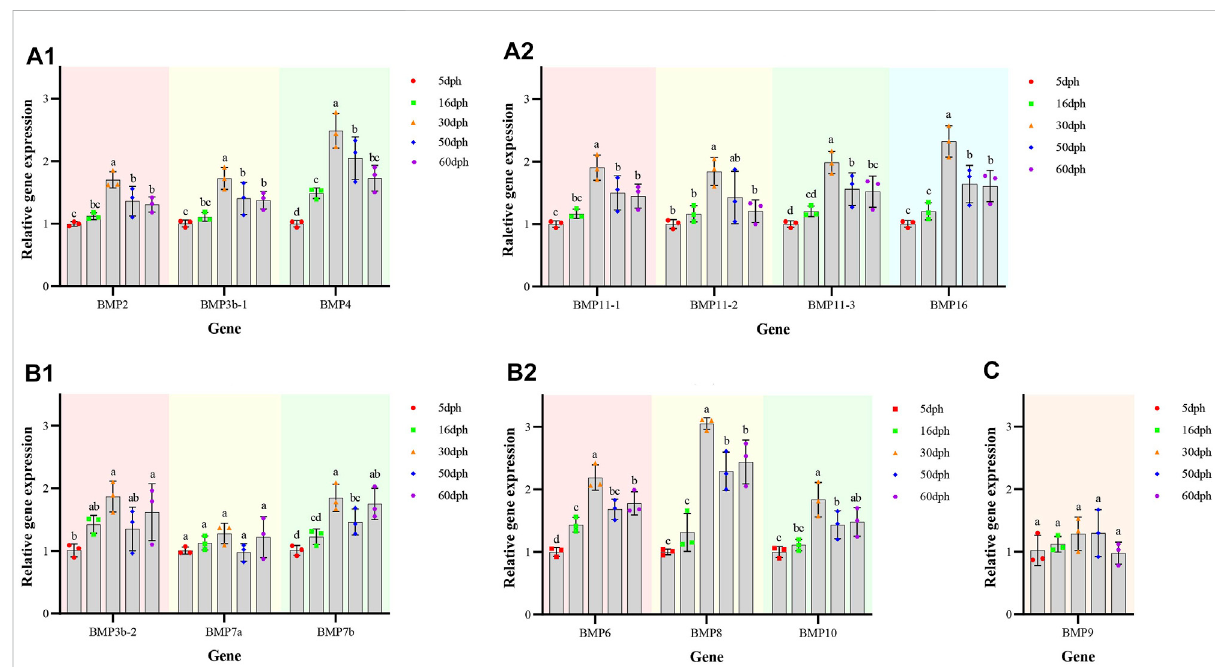
FIGURE 9 Relative expressionlevels of BMP genes inselecteddevelopmentalstagesof O. punctatus . (A1,A2) Represent temporalexpressionpattern one; (A1) shows the temporal expression pattern of BMP2, BMP3b-1 and BMP4; (A2) shows the temporal expression pattern of BMP11-1, BMP11-2, BMP11-3, and BMP16. (B1,B2) Represent temporal expression pattern two; (B1) shows the temporal expression pattern of BMP3b-2, BMP7a and BMP7b; (B2) shows the temporal expression pattern of BMP6, BMP8 and BMP10. (C) Represents temporal expression pattern three, the temporal expression pattern of BMP9